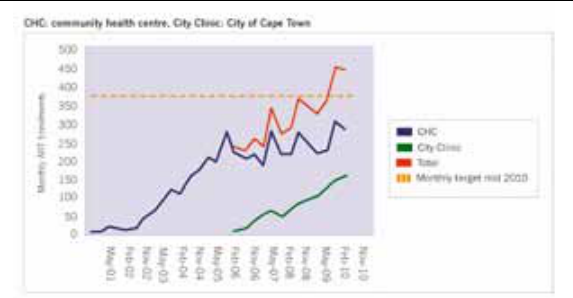
Fig. 3. Monthly patient ART enrollment, 2001 -